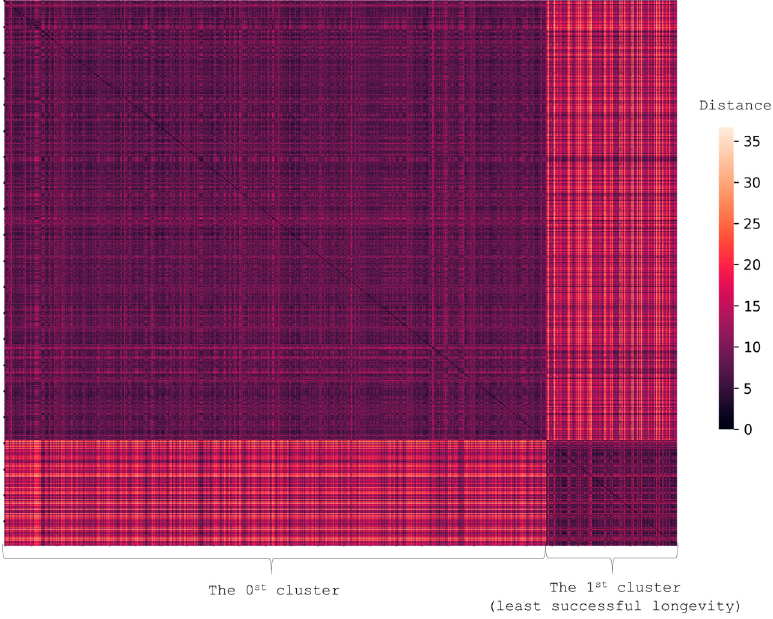
Figure 5. The heatmap shows two clusters — the least successful aging and the other one. Each person is represented by a vector with values showing the presence of AADs (cancer, CVD, DM2, and COPD) and scores on MMSE, FAB, and SPPB. The figure shows the pairwise distance matrix for the selected set of individuals in Euclidean space. The X-axis is selected set of individuals and the Y-axis is the same set (the matrix is symmetric). The lighter the pixels, the bigger the difference between the pair in terms of selected features. Table 5. Differences in the factors (only significant) in the least successful aging cluster. Cluster 1. The Least Cluster 0 p -Value Successful Aging